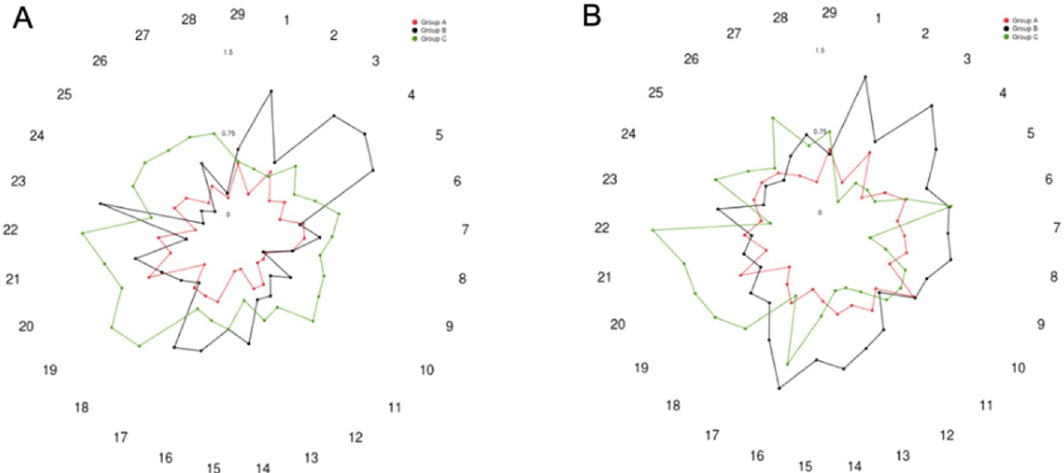
Figure 3. Different patterns of increased connectivity across subgroups assessed computing Cohen’s d for all significant connections in the whole sample analysis. The numbers represent the connections displayed in Table 4. Red represents group WM + MSL, black represents group MSL + WM and green represents the group WM × MSL. ( A ) session 1 versus session 3; ( B ) session 1 versus session 4.